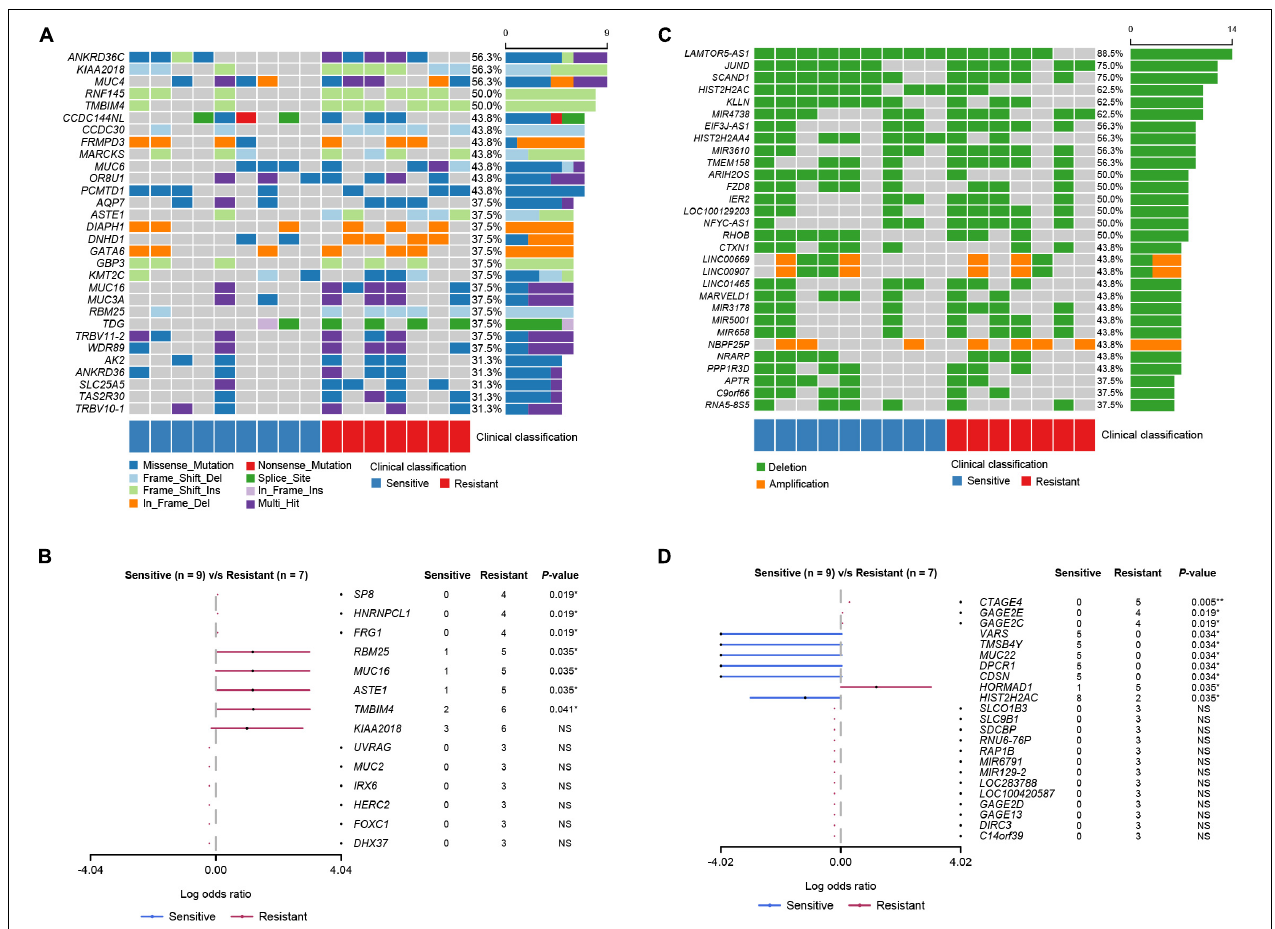
FIGURE 3 | Mutational landscape of the PCa patients. (A) The top 30 genes with SNV and Indel mutations. The percentage and horizontal bar on the right of each row indicate the fraction of patients with mutations in the corresponding genes and the composition of the types of mutations as color coded below the plot. (B) Somatic differentially mutated genes between the dicycloplatin-sensitive and dicycloplatin-resistant groups. The dots and horizontal bars denote the hazard rate and 5–95% confidence interval (CI), respectively. (C) The top 30 genes with CNV. The percentage and horizontal bar on the right of each row indicate the fraction of patients with CNV in the corresponding genes and composition of amplification (orange) or deletion (green). (D) Genes with differential CNV between the dicycloplatin-sensitive and dicycloplatin-resistant groups. The patients are grouped by their response to dicycloplatin. Blue: sensitive; red: resistant. The dots and horizontal bars denote the hazard rate and 5–95% CI in (B,D) . ** p < 0.01, * p < 0.05. NS, not